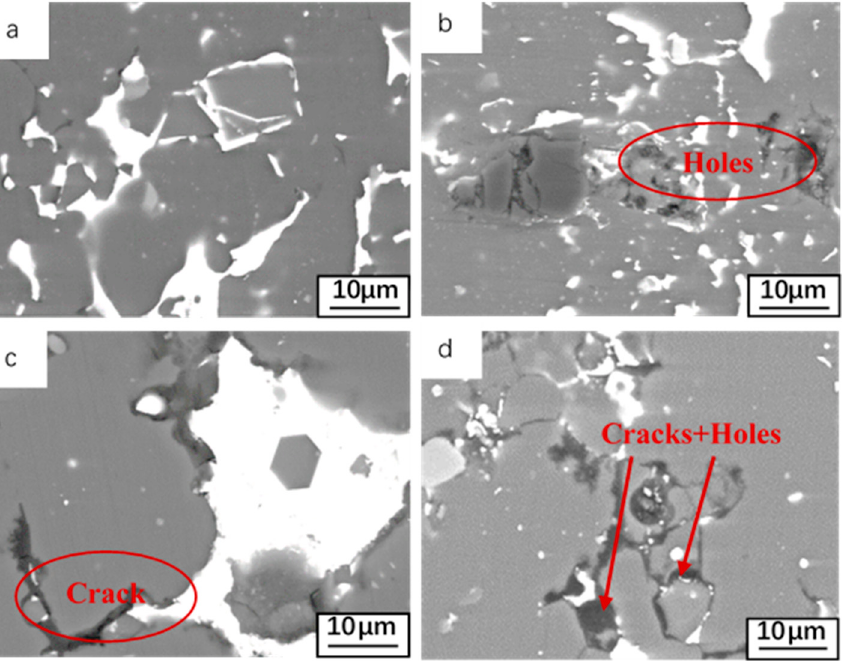
Figure 6. Microstructures after removing oxide film at different temperatures: ( a ) 25 °C; ( b ) 180 °C; ( c ) 300 °C; ( d ) 500 °C. ( c ) 300 ◦ C; ( d ) 500 ◦